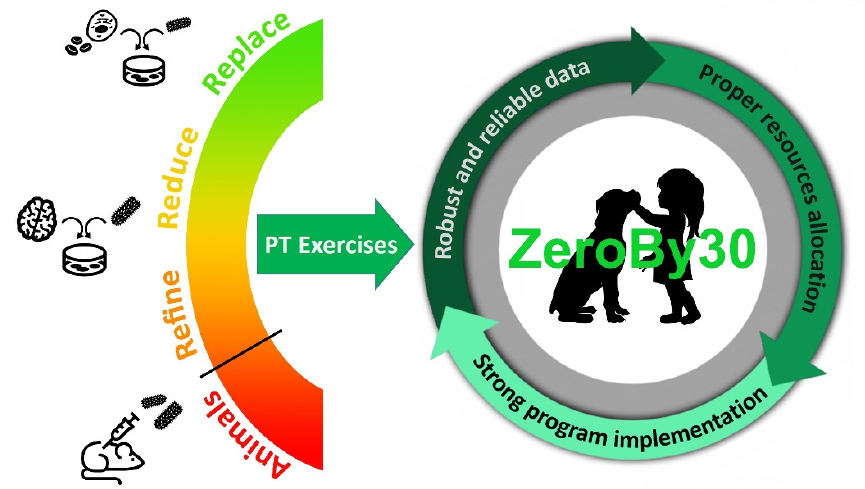
Figure 1. In vitro and ex vivo methods can potentially enable the implementation of the 3Rs tenet (Replacement, Reduction, Refinement) in the framework of rabies PT exercises, which in turn contribute to guaranteeing robust and reliable diagnostic data towards the ZeroBy30 global goal.